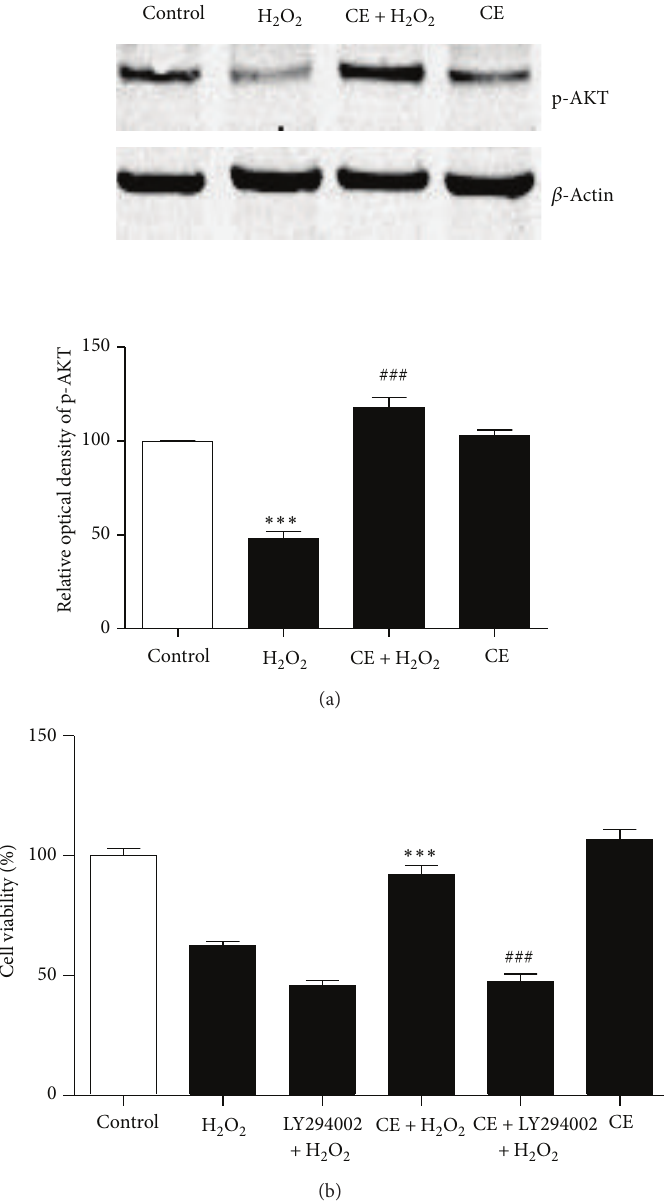
Figure 3: AKT signaling pathway is required for the neuroprotective effect of CE. (a) representative western blot probed with an antibody specific against p-AKT after various treatments in the neurons. Actin served as an internal control. Summary of the optical density of p- AKT. Results showed that CE significantly inhibited H 2 O 2 induced decreases in the content of p-AKT. ∗ refers to a comparison of the control group; # refers to a comparison of the H 2 O 2 group. (b) Bar graphs showing that the neuroprotective effect of CE was blocked by AKT inhibitor Ly294002, suggesting that AKT signaling pathway mediated the neuroprotective effect of CE in primary cultured cortical